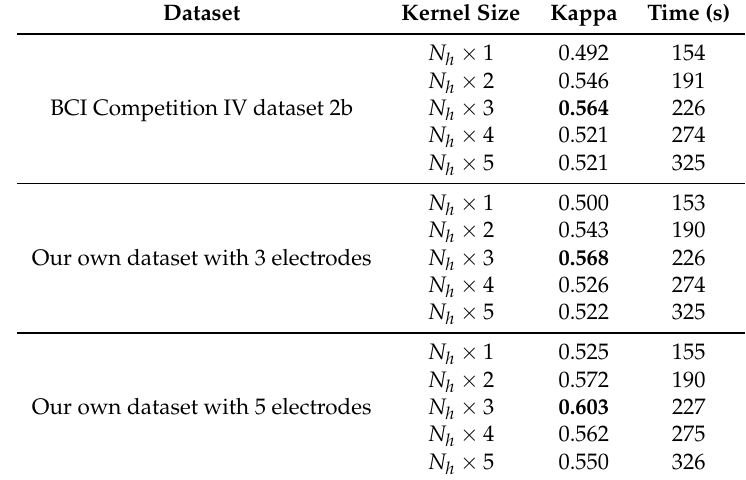
Table 7. Effect of kernel size on CNN. N h = 93, 93, and 155. (The data in bold is the best performance among the different methods).